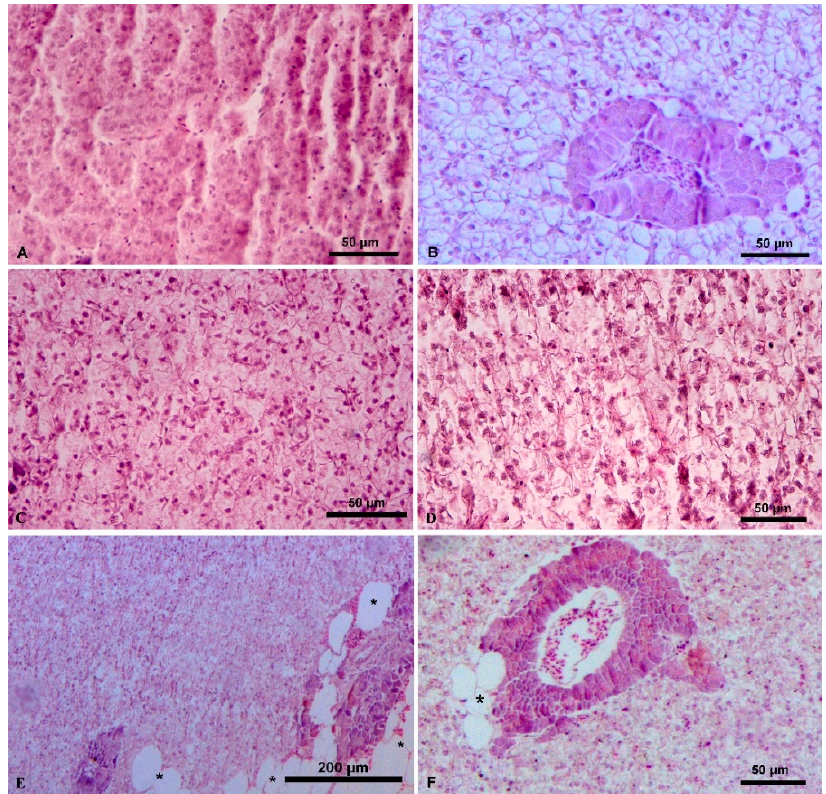
Figure 1. Liver histopathological examination of S. aurata fed on PBM diets. ( A ) fish fed FM diet—normal liver structure; ( B ) fish fed PBM25 diet—normal liver structure; ( C ) fish fed PBM25+ diet—normal liver structure; ( D ) fish fed PBM25+ diet—large lipid droplets (*) around pancreatic islets in some fish; ( E ) fish fed PBM50 diet—medium size lipid droplets with some nuclei pressed against the periphery of the cells; ( F ) fish fed PBM100 diet—liver degeneration.